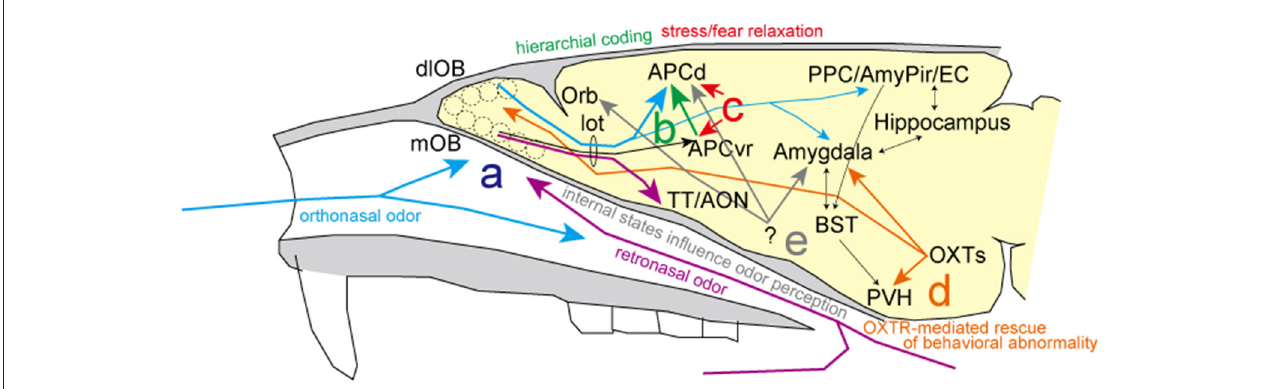
FIGURE1 Summary of the research topic. (a) There are two putative streams of odor information processing: the blue line shows the orthonasal/exteroceptive stream in lateral olfactory areas and the purple line shows the retronasal/interoceptive stream in the medial olfactory areas. (b) Hierarchical coding for the fine discrimination of odors (green line). (c) Selective inhibition systems to alleviate odor-induced stress responses in the anterior piriform cortex (red lines). (d) Oxytocinergic modulatory neurotransmission for resolving odor-related behavioral abnormalities (orange lines). (e) Changes in fMRI signals are found in parallel with behavioral changes and depend on the internal state, particularly with hunger and satiety. AmPir, amygdalo-piriform transition area; AON, anterior olfactory nucleus; APCd, dorsal part of the anterior piriform cortex; APCvr, ventro-rostral part of the anterior piriform cortex; BST, bed nucleus of the stria terminalis; EC, entorhinal cortex; lot, lateral olfactory tract; dlOB, dorsolateral wall of the olfactory bulb; mOB, medial wall of the olfactory bulb; Orb, orbitofrontal cortex; OXTs, oxytocin neurons; PPC, posterior piriform cortex; PVH, paraventricular hypothalamic nucleus; TT, tenia